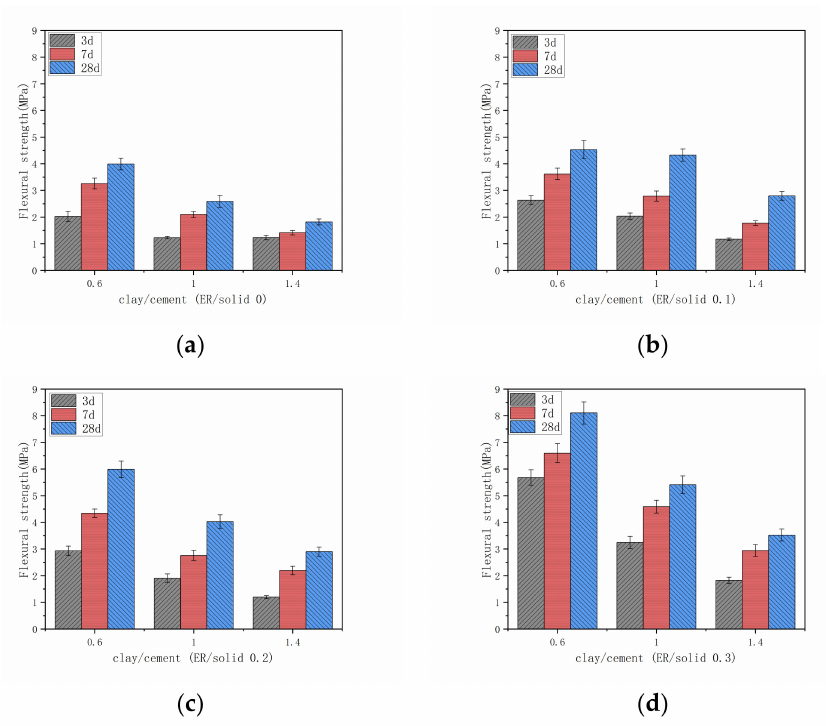
Figure 8. Flexural strength of grout with different admixtures of clay and cement. ( a ) ER/solid 0; ( b ) ER/solid 0.1; ( c ) ER/solid 0.2; ( d ) ER/solid